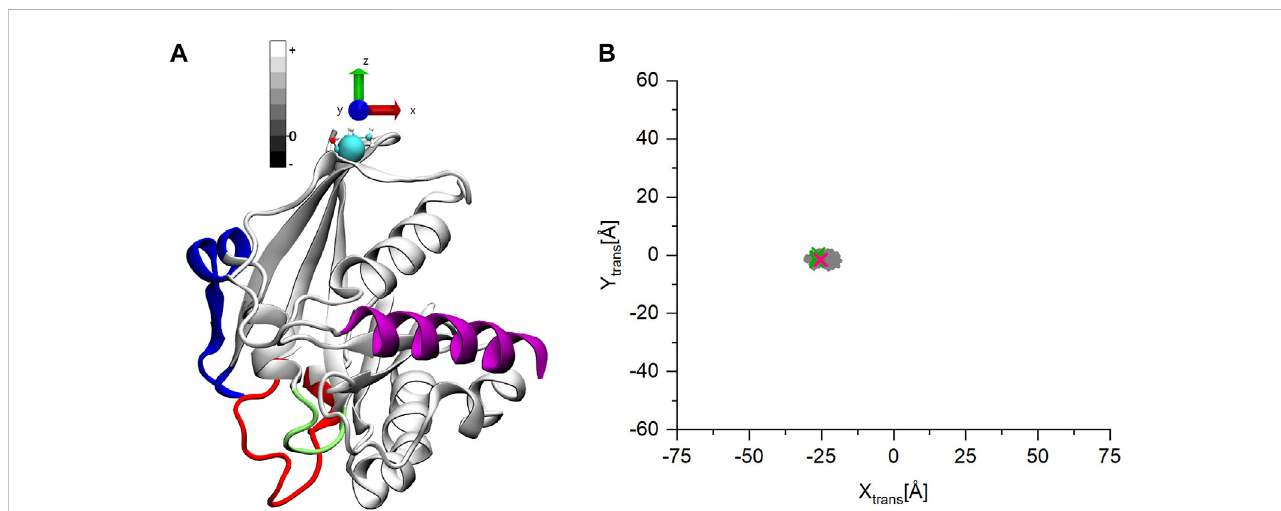
FIGURE 4 (A) The starting structure fortheMDsimulations ofran-GDPafterthecoordinatetransformation. (B) The coordinates ofthecenterofmass(COM) ofthe C-terminal helix on the x-y plane. The points are gray-scale-coded depending on their z coordinate values. The pink mark denotes the starting structure, the green the coordinates are of the other experimentally determined